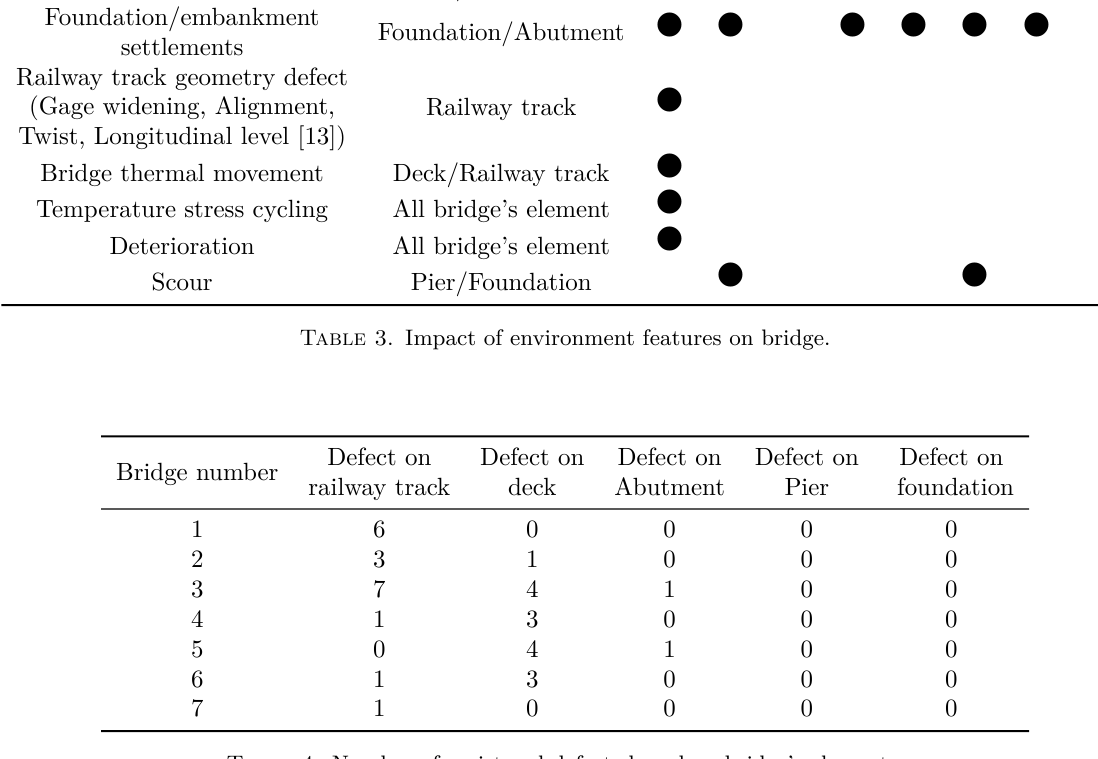
Table 4. Number of registered defects based on bridge’s elements.